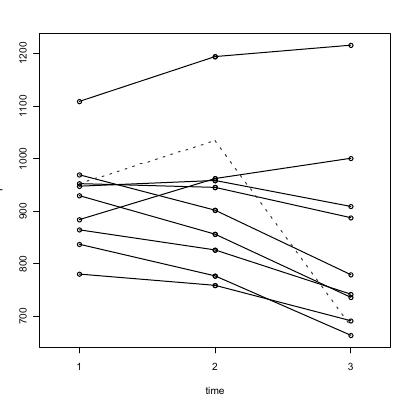
Figure 4 – The showed time series have a sea- sonal component at t =3 and t =7.